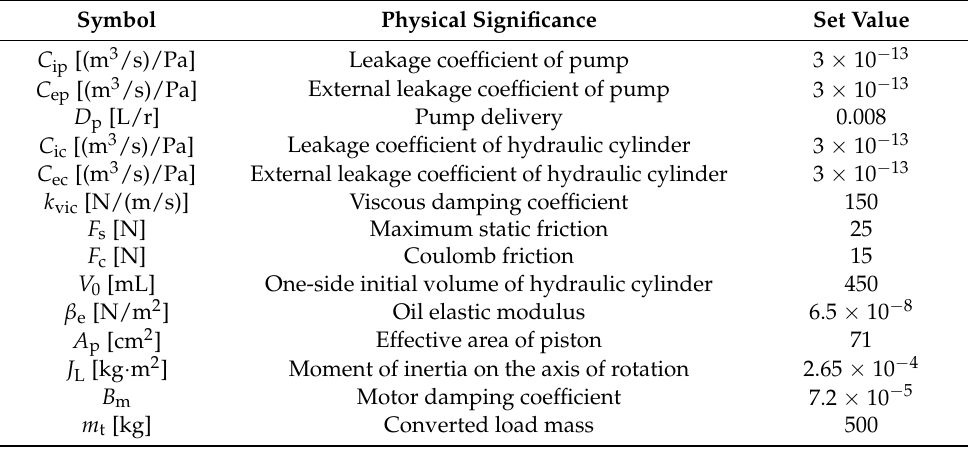
Table 4. System simulation parameter settings.